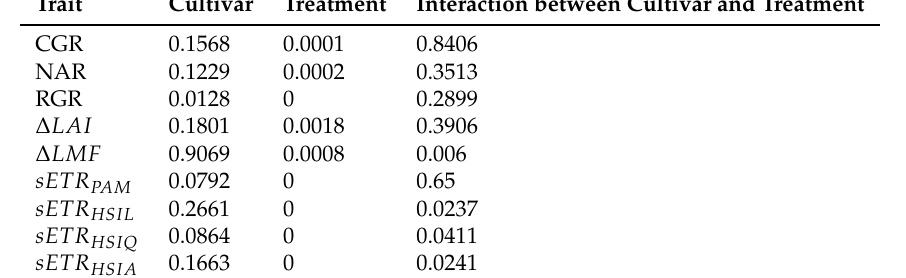
Table 2. The p -values of ANOVA tests on the growth traits, and standardized ETR values estimated using four approaches.